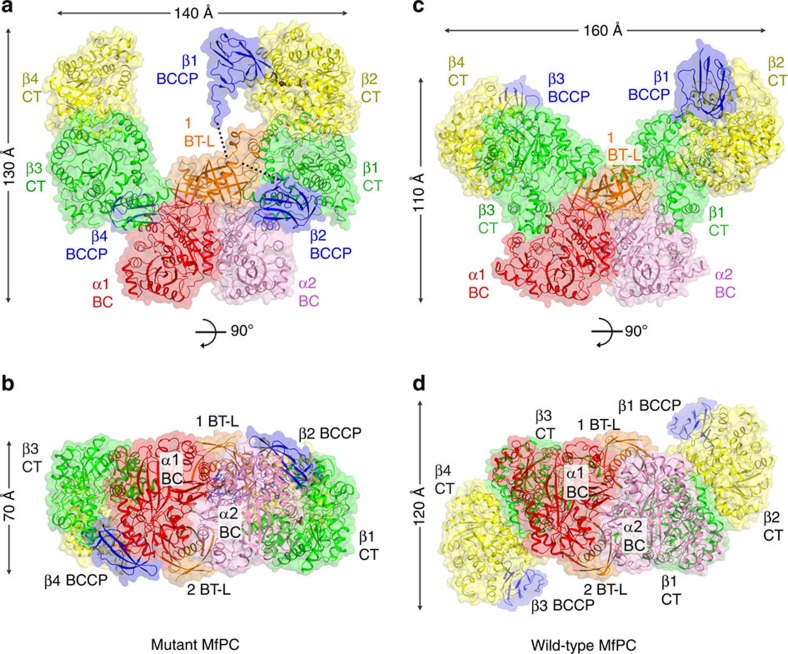
Structures of MfPC holoenzyme.(a) Schematic drawing of the mutant MfPC α2β4 holoenzyme structure, having the shape of the letter U in this view. The domains are coloured according to Fig. 1a, except the BC domain of the second α subunit is coloured in pink. BT-L, BT-like domain. (b) Structure of the mutant MfPC holoenzyme viewed down the BC domain dimer, along the arrow of a. (c) Structure of wild-type MfPC holoenzyme, having the shape of a butterfly in this view. (d) Structure of the wild-type MfPC holoenzyme viewed down the BC domain dimer, along the arrow of c. The two distal β subunits (β2 and β4) are splayed away from each other, and other differences to the mutant MfPC holoenzyme are also clearly visible by comparing with b.